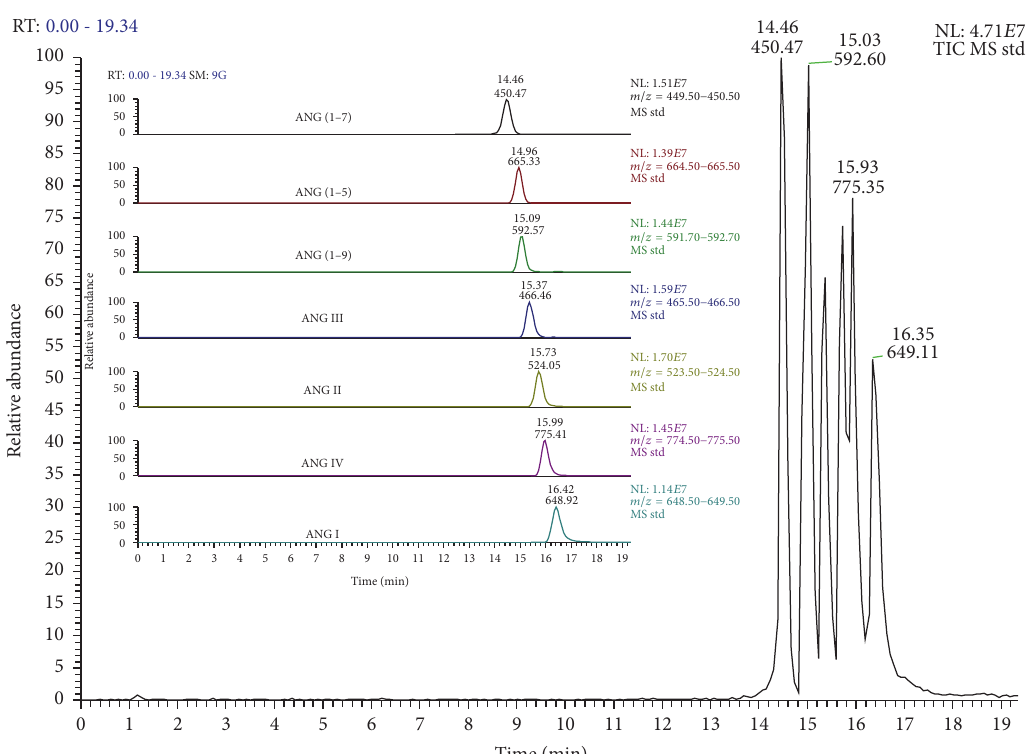
Figure 2: Representative chromatogram of angiotensins standards mixture. Insert: chromatograms of extracted monitored ions of each analyzed